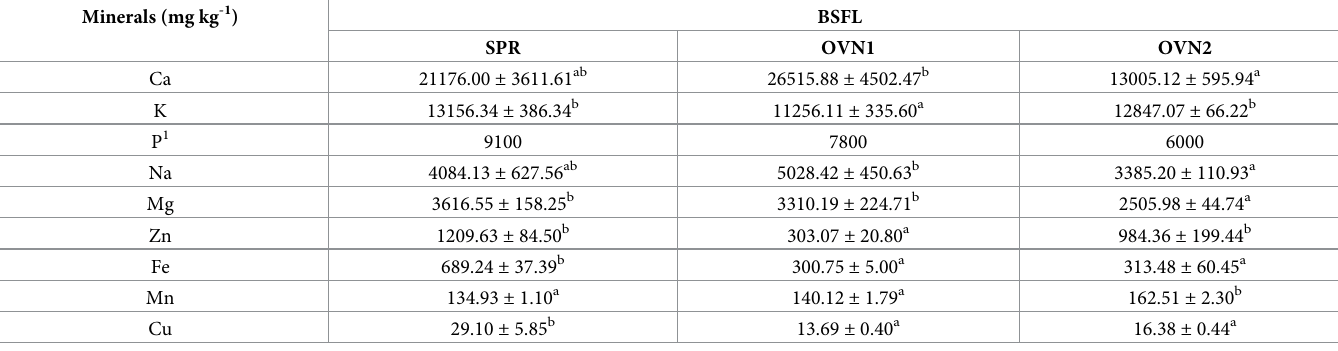
Results are means ± SE of analysis of three samples (n = 3). 1